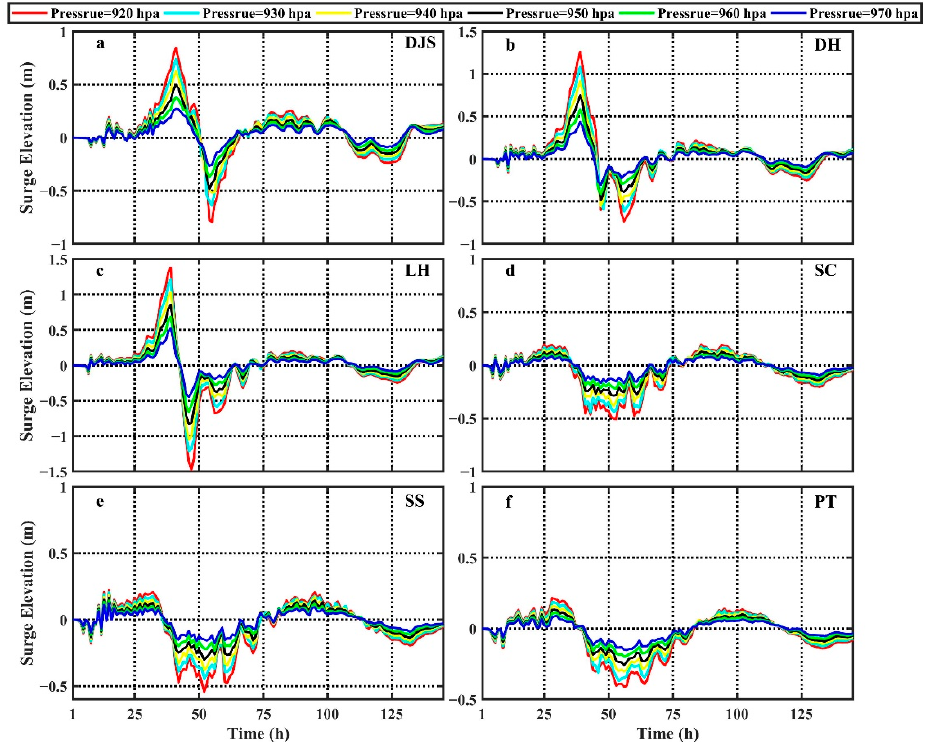
Figure 9. Time series of surge elevation in experiments with different central pressure at: ( a ) DJS, ( b ) DH, ( c ) LH, ( d ) SC, ( e ) SS, and ( f ) PT.